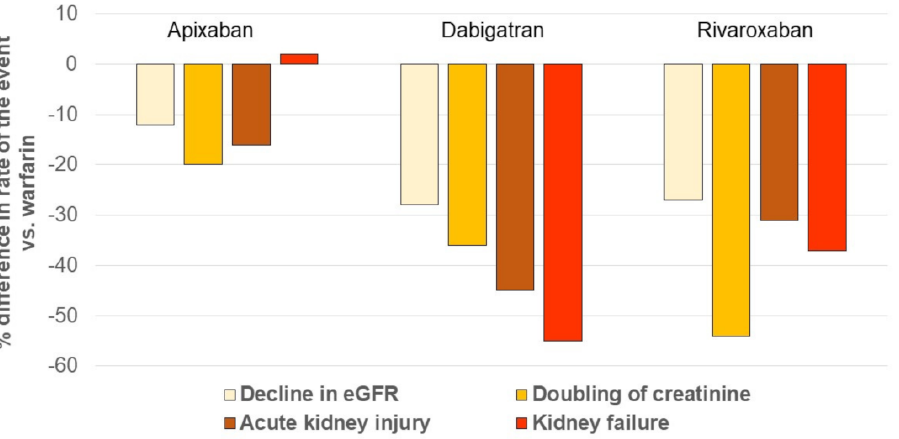
Figure 4. Incidence of renal outcomes in patients with AF receiving NOACs, compared with the one in patients taking warfarin. The figure was drawn based on the published data in reference [82]. AKI: acute kidney injury, defined as hospitalization or emergency department visit with a primary or secondary diagnosis code of AKI; eGFR: estimated glomerular filtration rate. Kidney failure was defined as eGFR lower than 15 mL/min per 1.73 m 2 , having a kidney transplant, or undergoing long-term